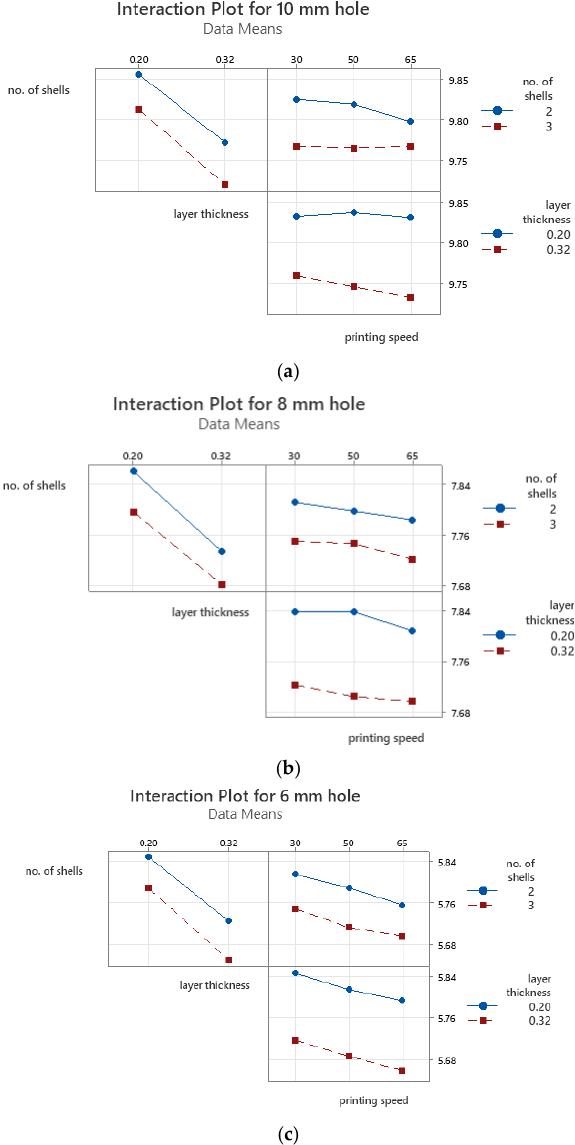
Figure 5. Interaction plots for the holes dimensional accuracy ( a ) 10 mm holes; ( b ) 8 mm holes; ( c ) 6 mm holes.